Question: Give a one-sentence summary of this figure.
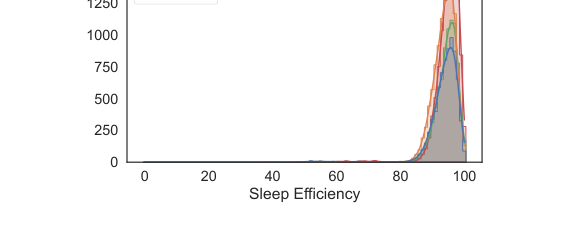
Answer: Sleep Efficiency distribution throughout 4 years of GLOBEM dataset (2018 to 2021)